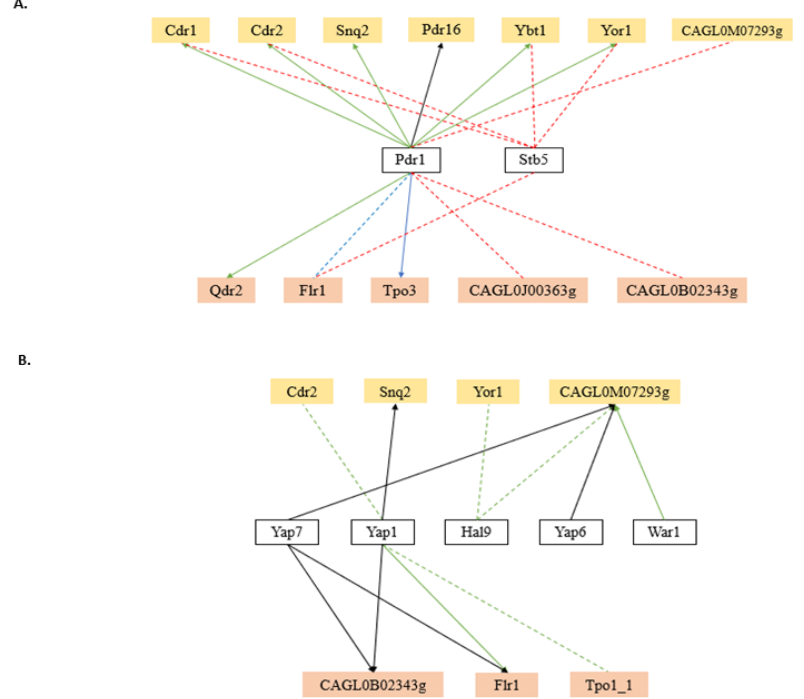
Figure 3. Transcriptional regulatory networks that control the expression of MDR transporter genes in C. glabrata , considering the subgroups of transcription factors known to be involved in multidrug resistance ( A ) and in stress response ( B ). The displayed regulatory associations are according to the data present in the Pathoyeastract database (http://pathoyeastract.org/) [161]. ABC transporters are highlighted by the yellow colour and MFS transporters are highlighted by the orange colour. Arrows indicate the experimental basis of the documented regulatory associations, either expression evidence (dashed line) or DNA-binding evidence (filled line). Green, red, blue, or black arrows indicate a positive, negative, positive and negative, or unspecified association, respectively.